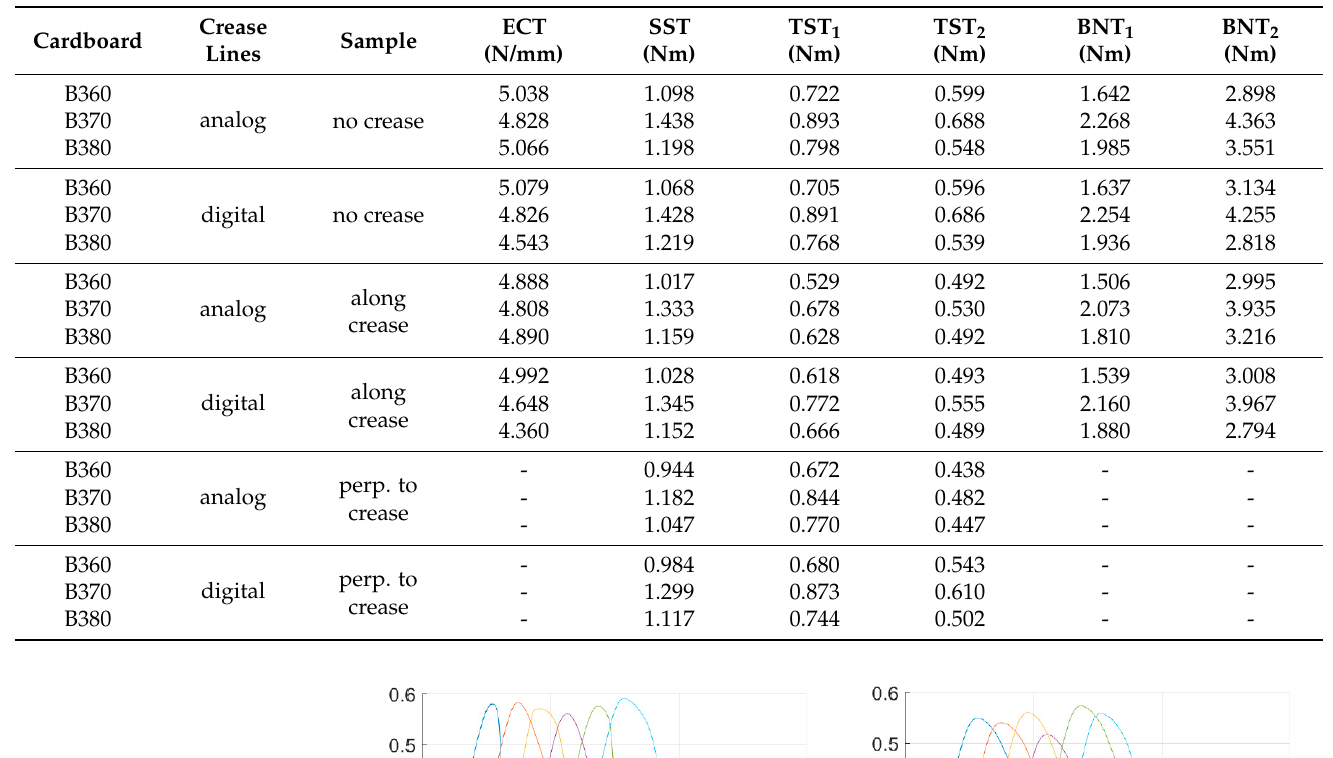
Table 2. Averaged test results for corrugated board with different types of cardboard, production technology, and sampling region.